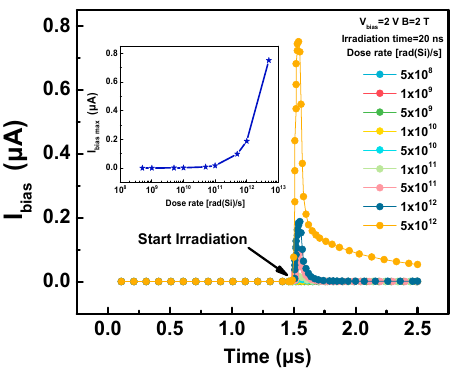
Figure 5. Transient dose rate (TDR)-induced currents in the FD-SOI Hall sensors. The inset shows the change of the detected maximum bias current ( I bias ) with dose rate.